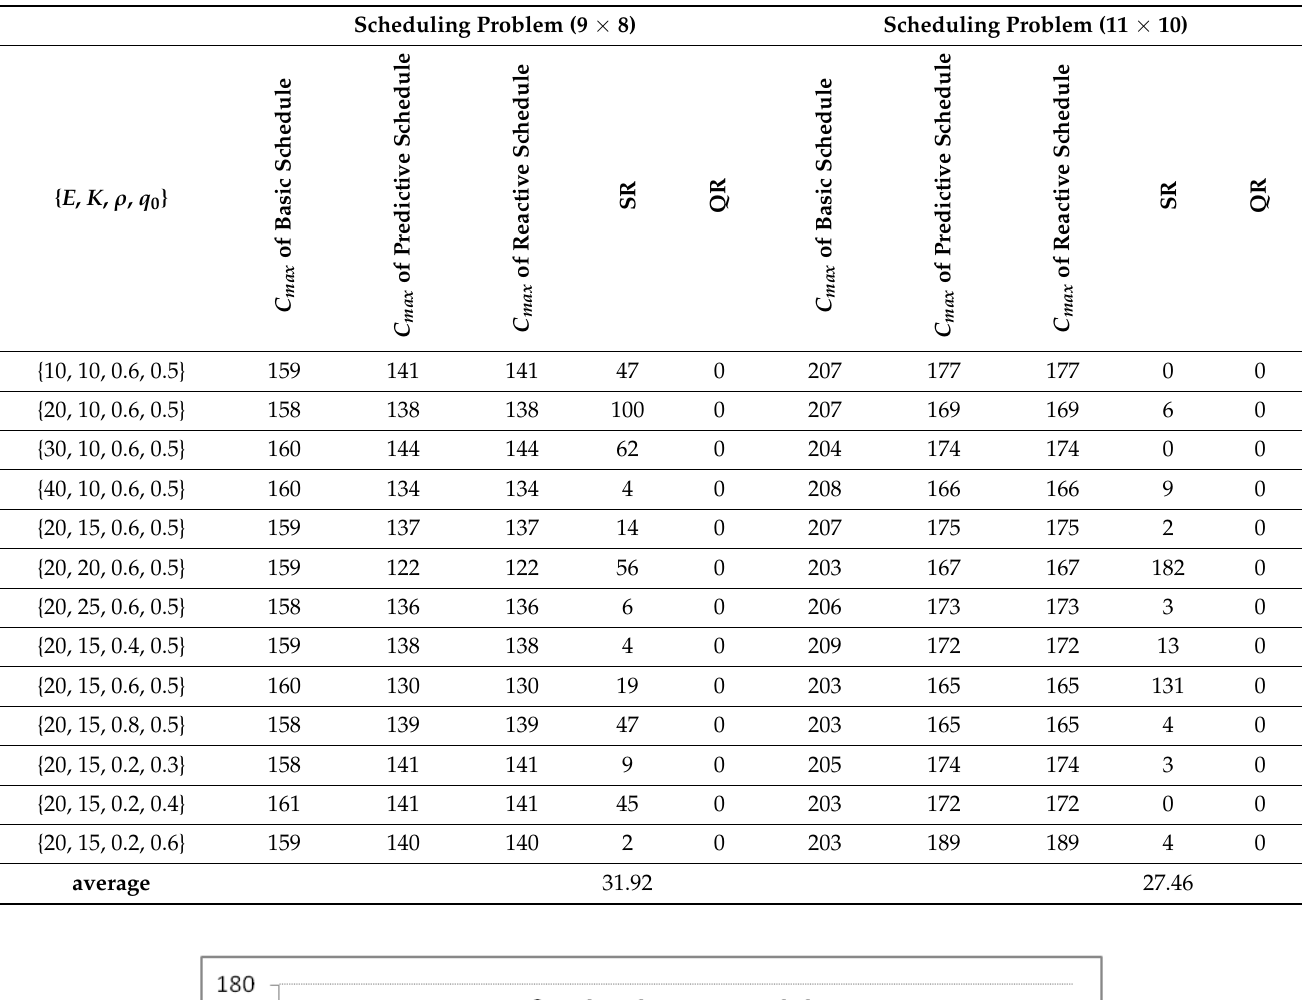
Table 2. The schedules generated using the MIDOS II and MIROS for the best basic schedules achieved by the ACO and input parameters { ρ , K , E , q 0 }.